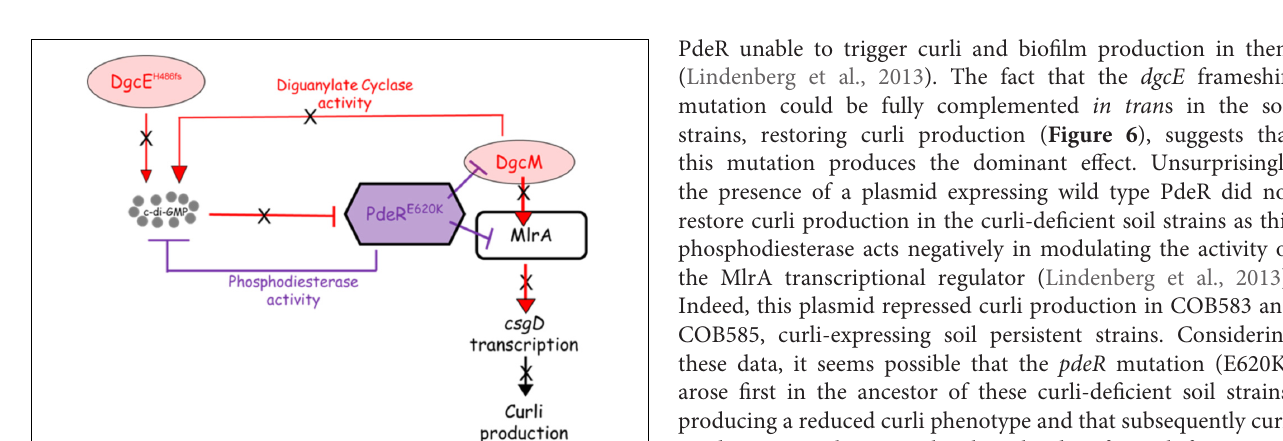
FIGURE 8 | Curli-positive Escherichia coli attach better to quartz sand than curli-negative E. coli. Attachment of E. coli strains to quartz sand was determined after 28 ◦ C at 48 h. Planktonic cell counts (A,C) and biofilm cell counts (B,D) were determined under same condition for the wildtype and for dgcE -complemented curli-negative strains. Multiple comparison of the means using one-way ANOVA shows significant differences (represented by asterisks) between the curli-positive and curli-negative strains. ∗ p < 0.05; ∗∗ p < 0.01; ∗∗∗ p < 0.001; ∗∗∗∗ p < 0.0001.